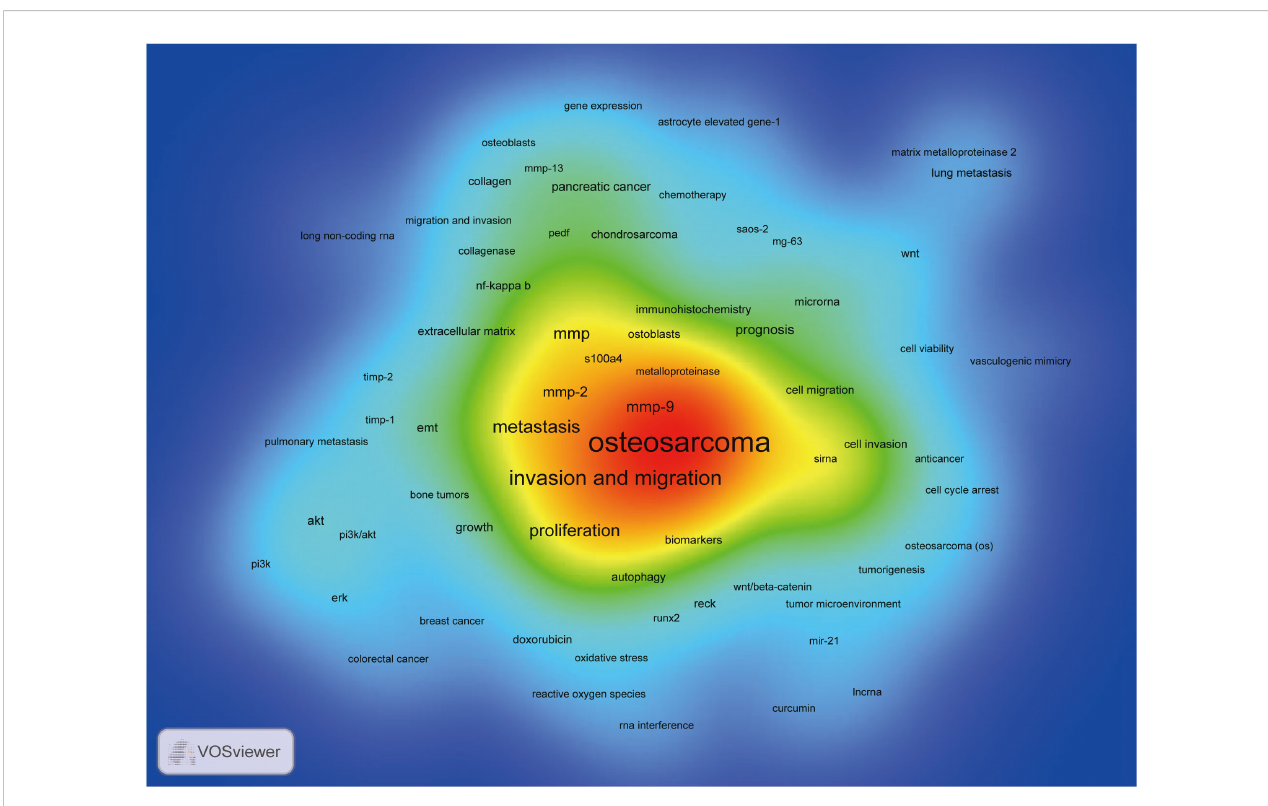
FIGURE 7 The density map of terms in MMP-OS research (T ≥ 6), The size of word, the size of round, and the opacity of red is positively related to the co- occurrence frequency.